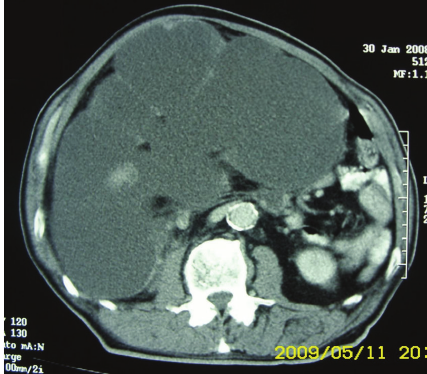
Figure 1: CT of the abdomen showing giant hydronephrosis.